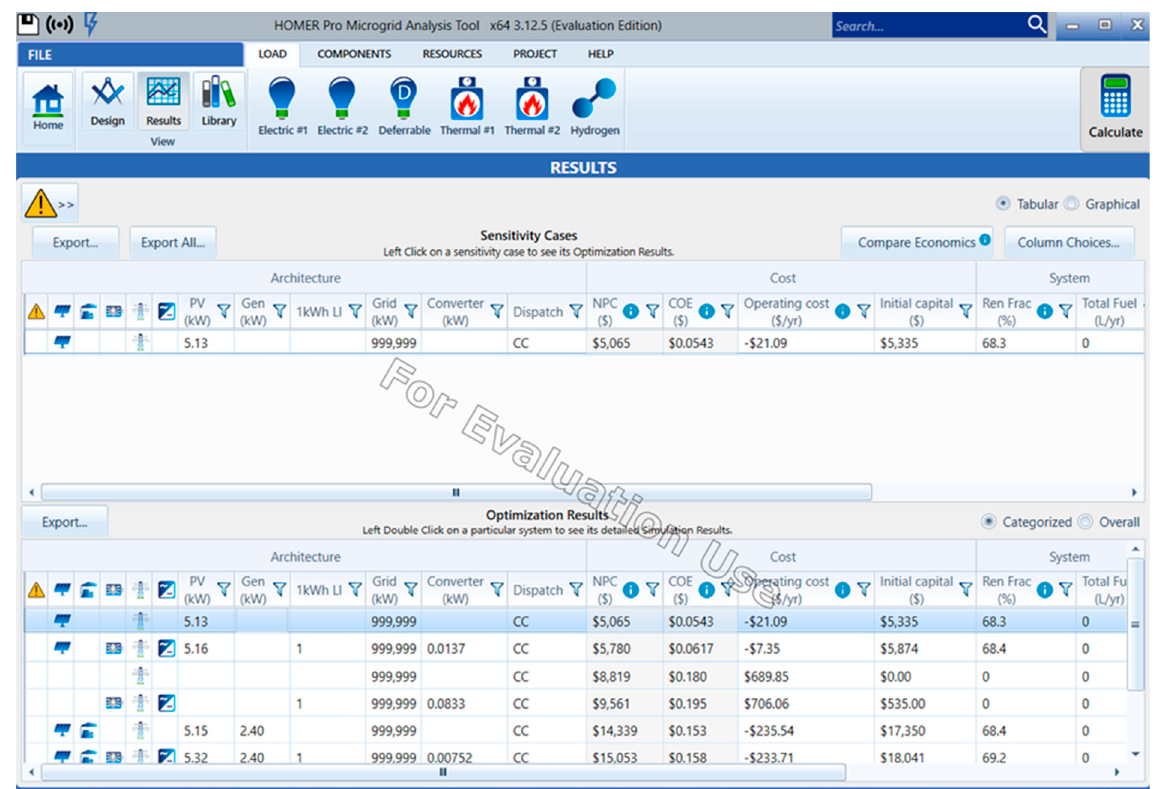
Figure 20. Výsledky simulace jedenoho scéná ř e s výchozími hodnotami. Figure 20. V ý sledky simulace jedenoho sc é n á ˇre s v ý choz í mi hodnotami.